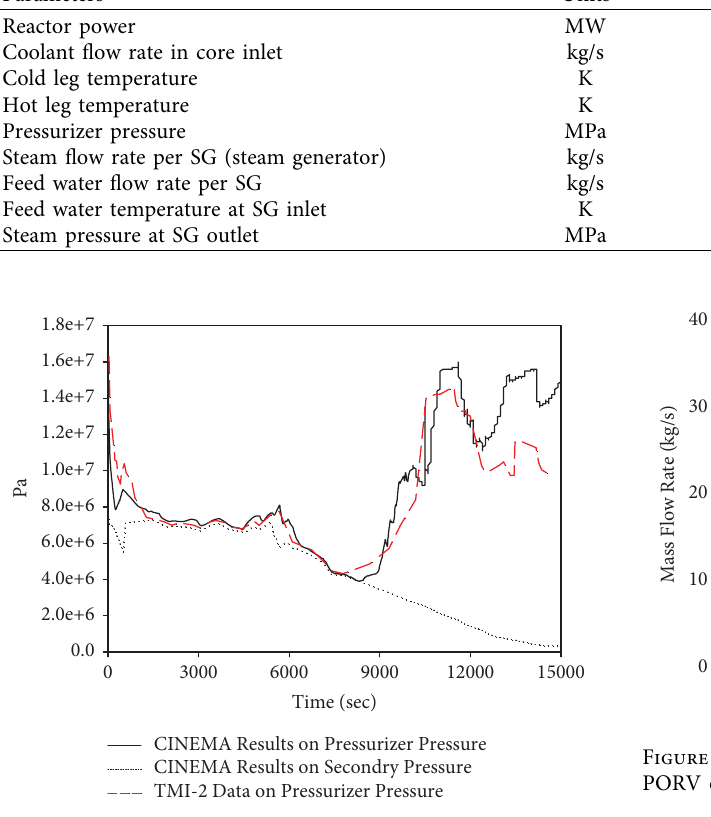
Figure 4: Comparison of CINEMA results with TMI-2 data on the pressurizer pressure.